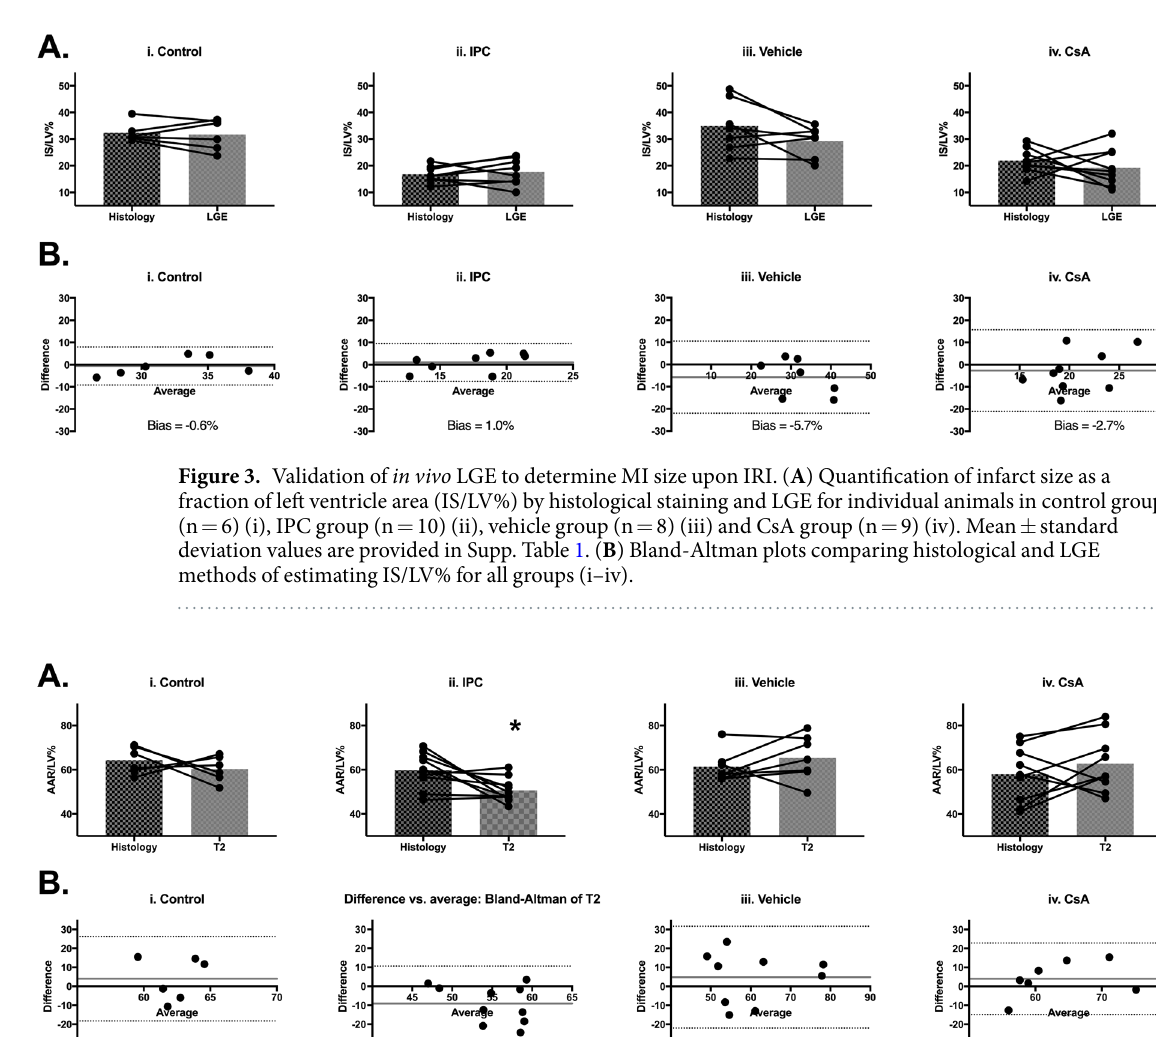
perfusion from 1 SD threshold [mg/g/ml]: vehicle group 16.9 ± 0.8, n = 6 versus CsA group 28.9 ± 11.1, n = 8,